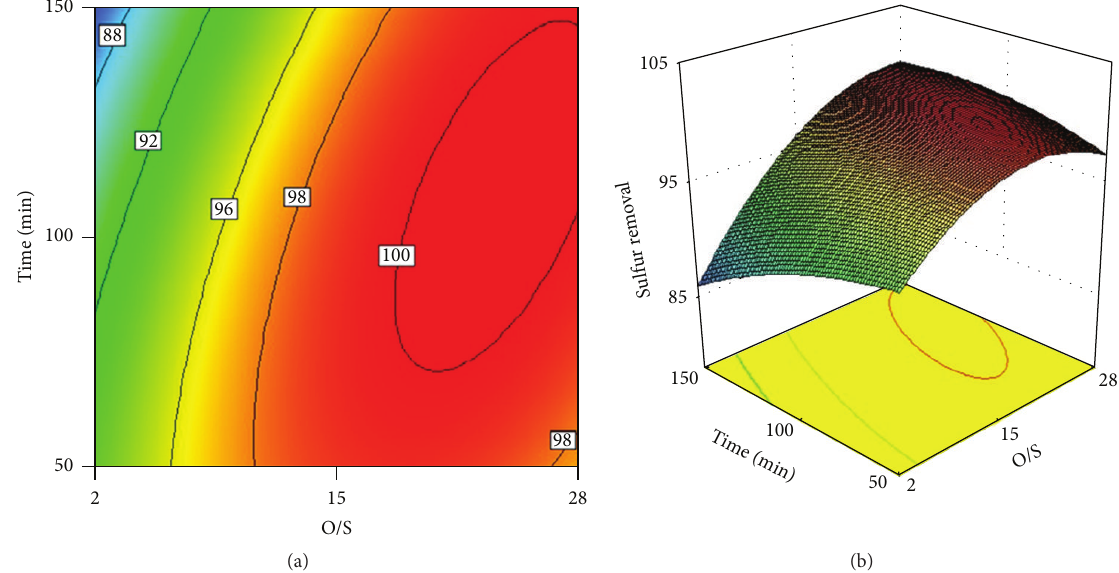
Figure 3: (a) 2D contour plot and (b) 3D response surface curve of the constructed model displaying sulfur removal at different O/S and time. Oxidation condition: T = 65 ∘ C; aqueous phase pH = 1.5; acid/S = 20. Extraction condition: T = 22 ∘ C; solvent-to-oil volume ratio = 1; number of extraction stages =